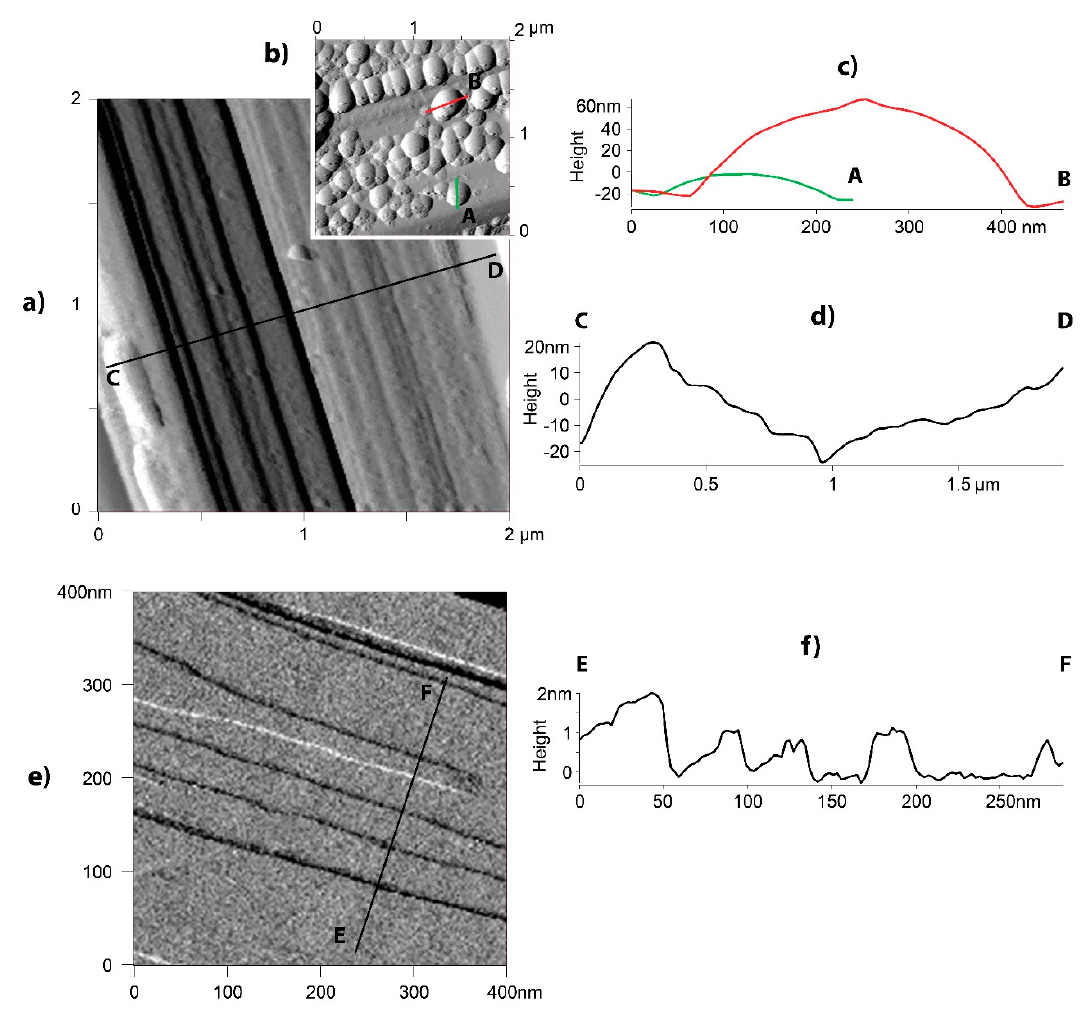
Figure 3. Amplitude retrace AFM images of erionite MB2404 surface in MilliQ water at 25 °C, at different magnifications: ( a ) typical clean surface (without particles) and related section ( d ); ( b ) particular of an area covered by particles and corresponding sections ( c ); ( e ) particular of steps parallel to c-direction and related section ( f ).